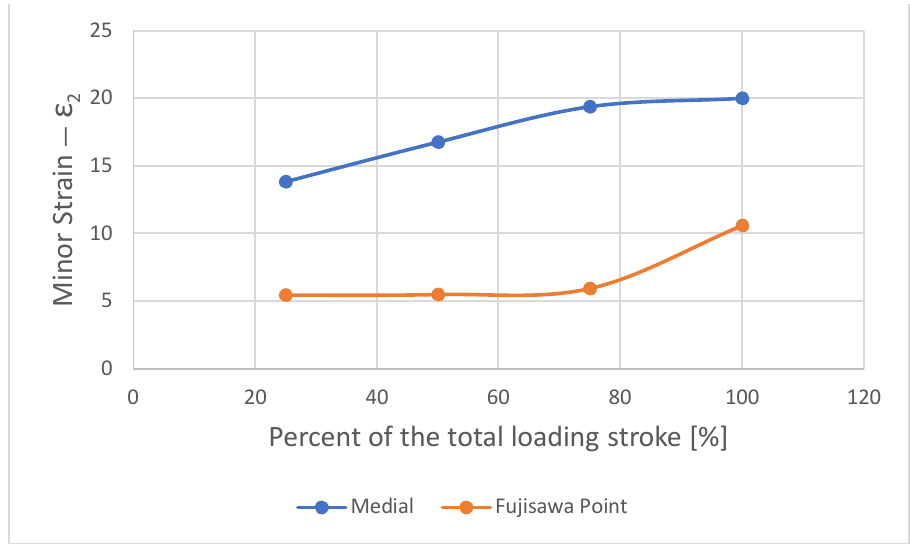
Figure 11. Variations of the major strain ε 1 during medial and offset loading (Fujisawa point).